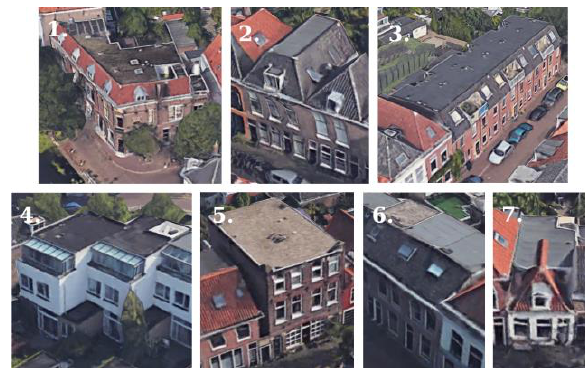
Figure 7. Are these roofs flat or not? Images from © Google